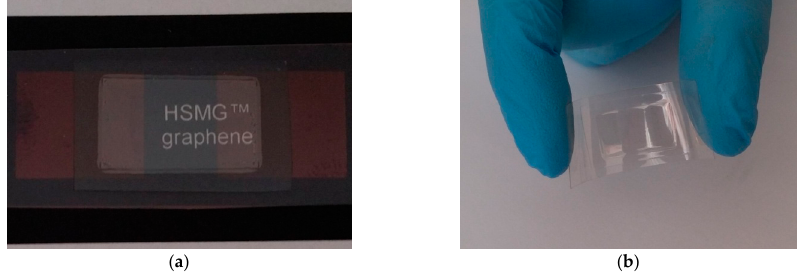
Figure 4. Examples of fully transparent temperature sensors: ( a ) transparency of cryogenic sensor—photo of the sensor on a black background with a white label; ( b ) stretchability of the sensor.